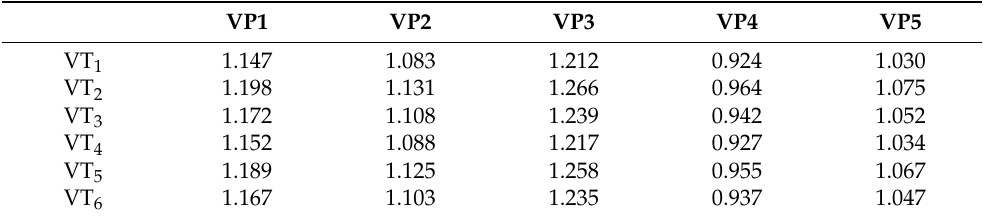
Table 9. Average values of correspondence between VT i and VP j in the third approach of the